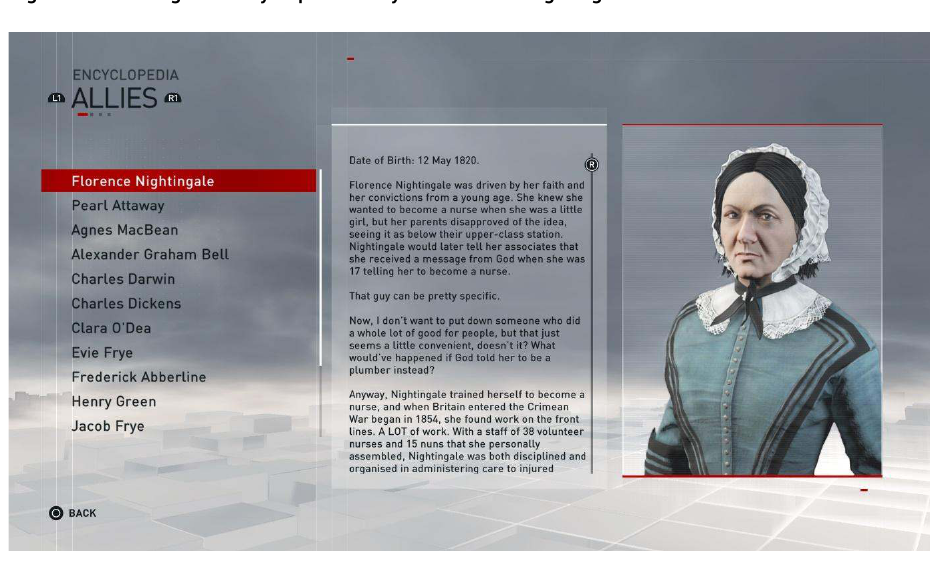
Figure 12: The in-game encyclopedia entry for Florence Nightingale and her model